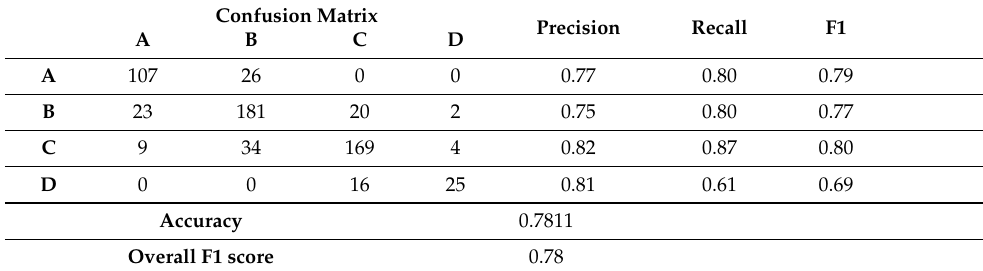
Table 17. Weighted average ensembles with best 4 models.